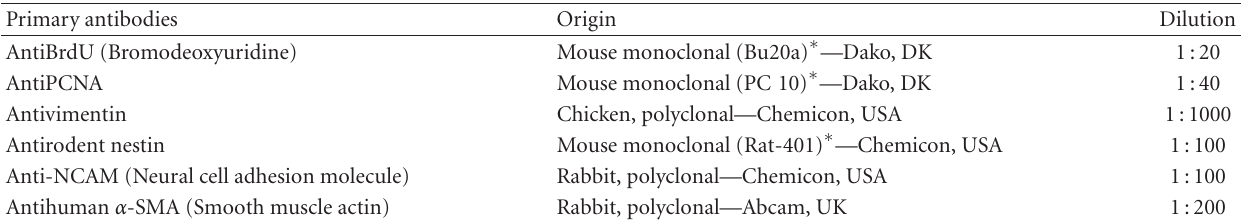
Table 1: Antibodies used for the immunohistochemical characterization of interstitial cells in rat